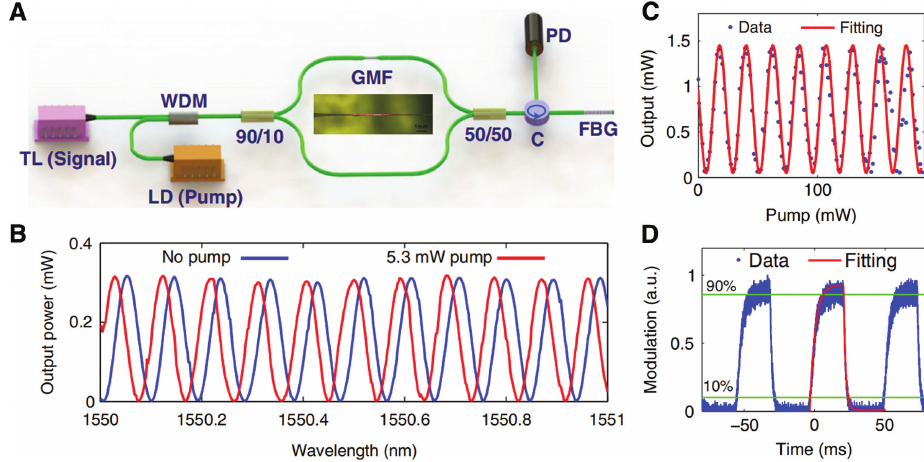
Figure 17: All-fiber phase shifter and optical switching based on GMF. (A) Schematic of the experimental setup for measuring the phase shift in GMF. (B) Measured interference fringes without (blue) and with (red) pump. (C) All-optical switching by the GMF. (D) Temporal response of the optical switching. Reproduced with permission [277]. Copyright 2015, The Optical Society.